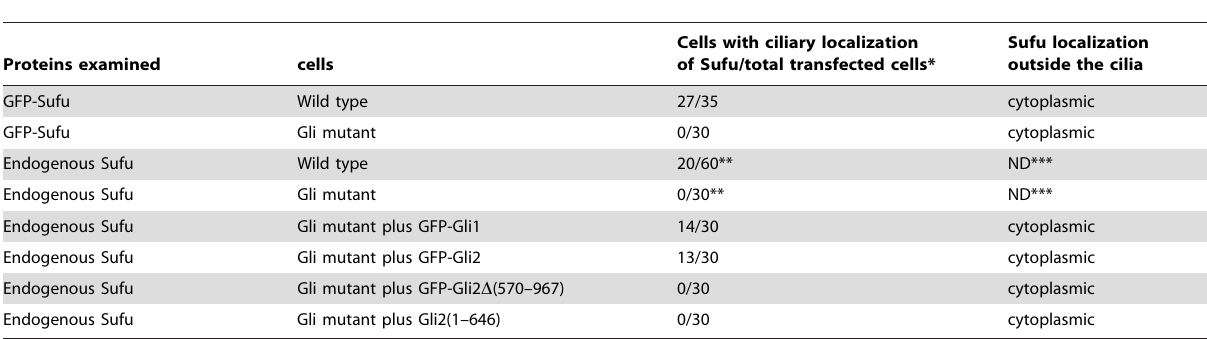
Table 3. Subcellular localization of over-expressed and endogenous Sufu in ciliated fibroblasts.